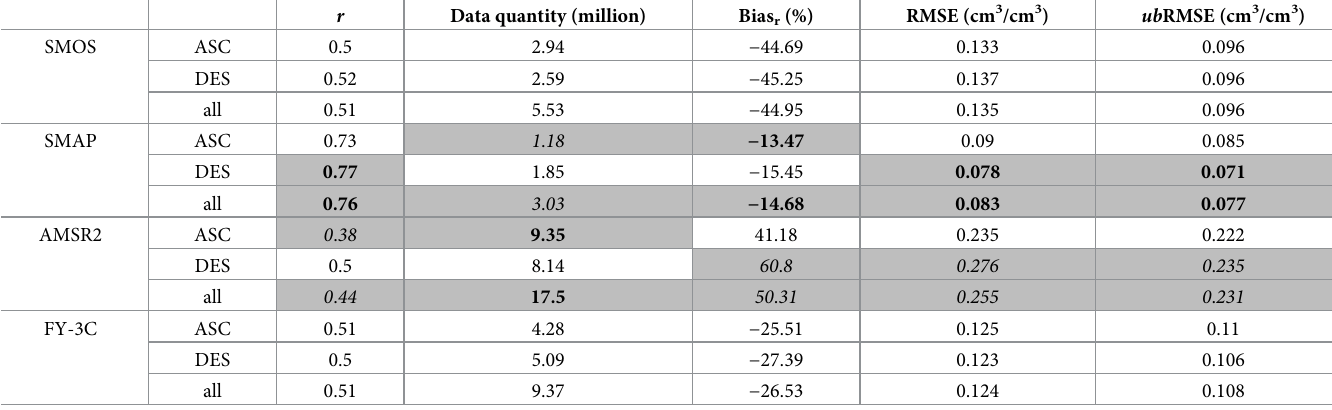
Table 2. Indicator values for comparison of remote sensing data with GLDAS